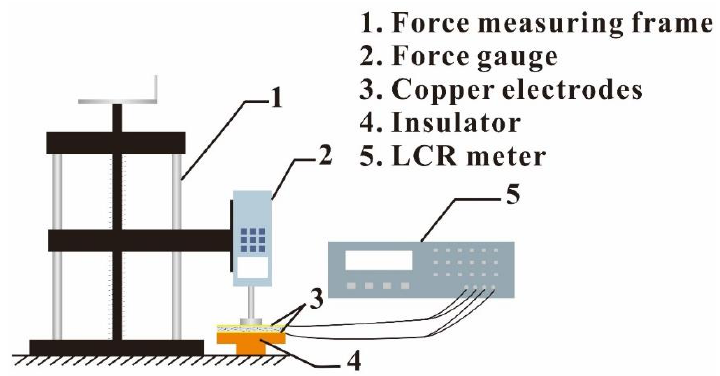
Figure 2. The schematic diagram for the piezo-capacitive effect experimental setup.